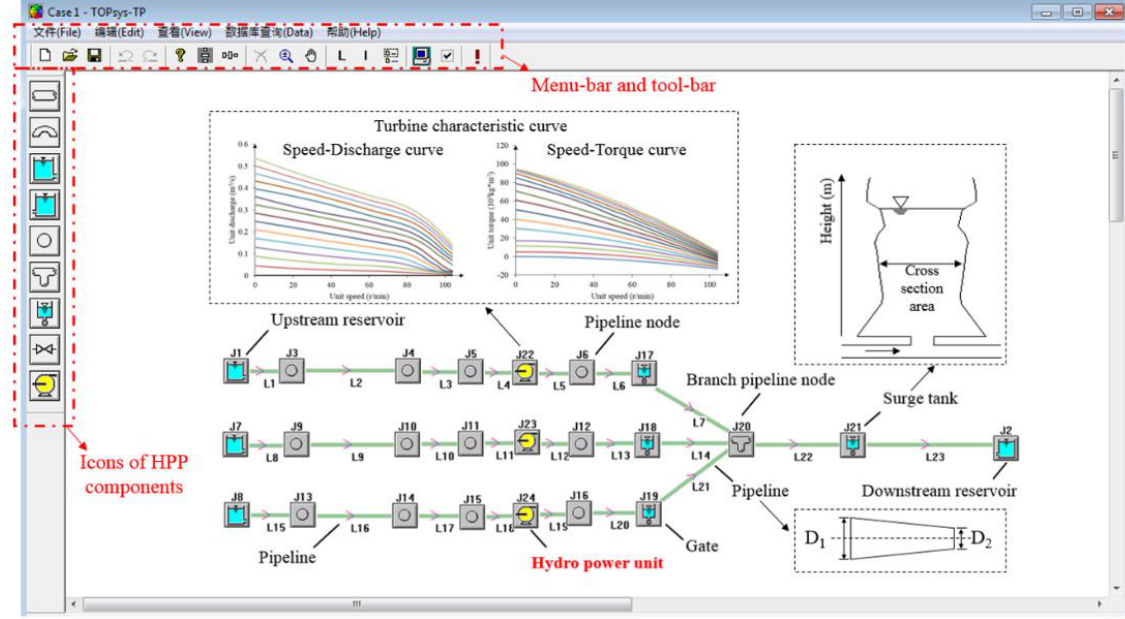
Figure 1. Graphical user interface of TOPSYS and a model of a Swedish hydro power plant (HPP) (Case 1 in Section